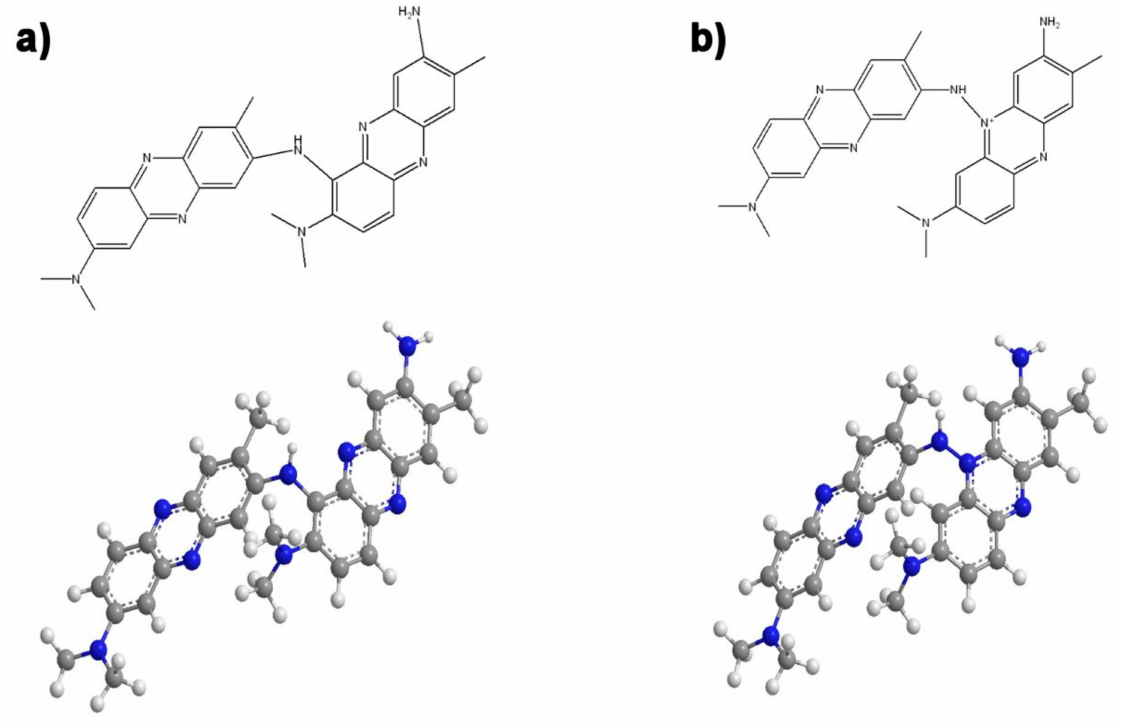
Figure 6. Possible connection of NR units in the polymer (PNR) via the position marked 6 ( a ) or the nitrogen of the phenazine ring NR ( b ). (Molecular formulas and optimized model structures are